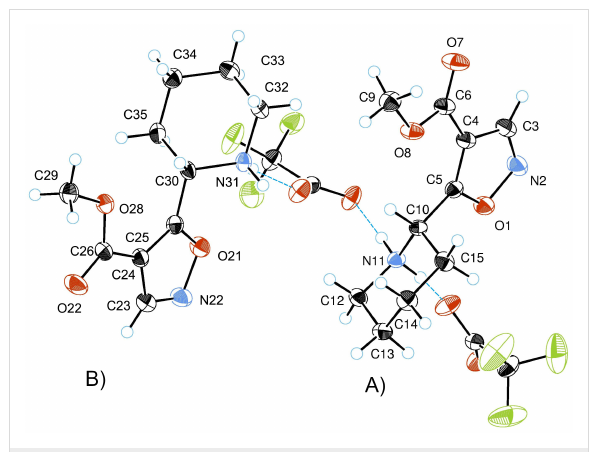
Figure 5: ORTEP diagram of the asymmetric unit consisting of two cations 6b ( A ) and 6b ( B ) and triflate